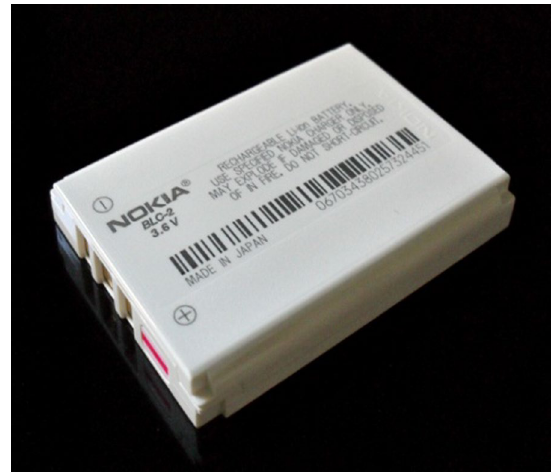
Fig. 11 A Li-ion battery from a Nokia mobile phone (https:// en. wikip edia. org/ wiki/ Lithi um- ion_ batte